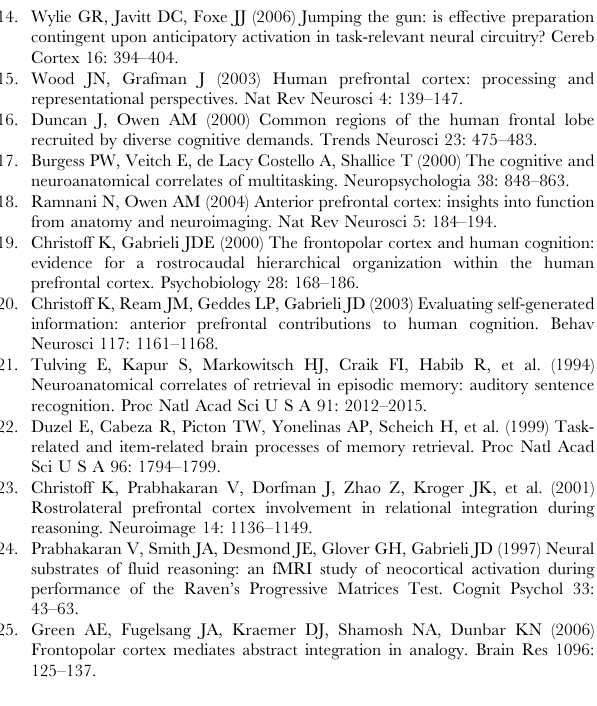
Table S2 Correlation coefficient in the dual-task condition for each possible n-1 subset of data